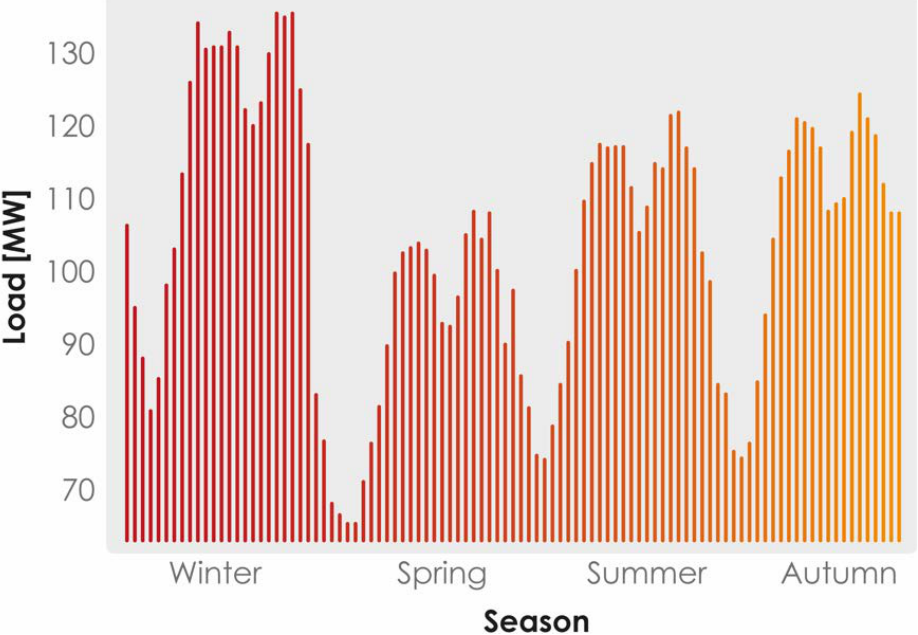
Figure 2. Irradiance for each location.